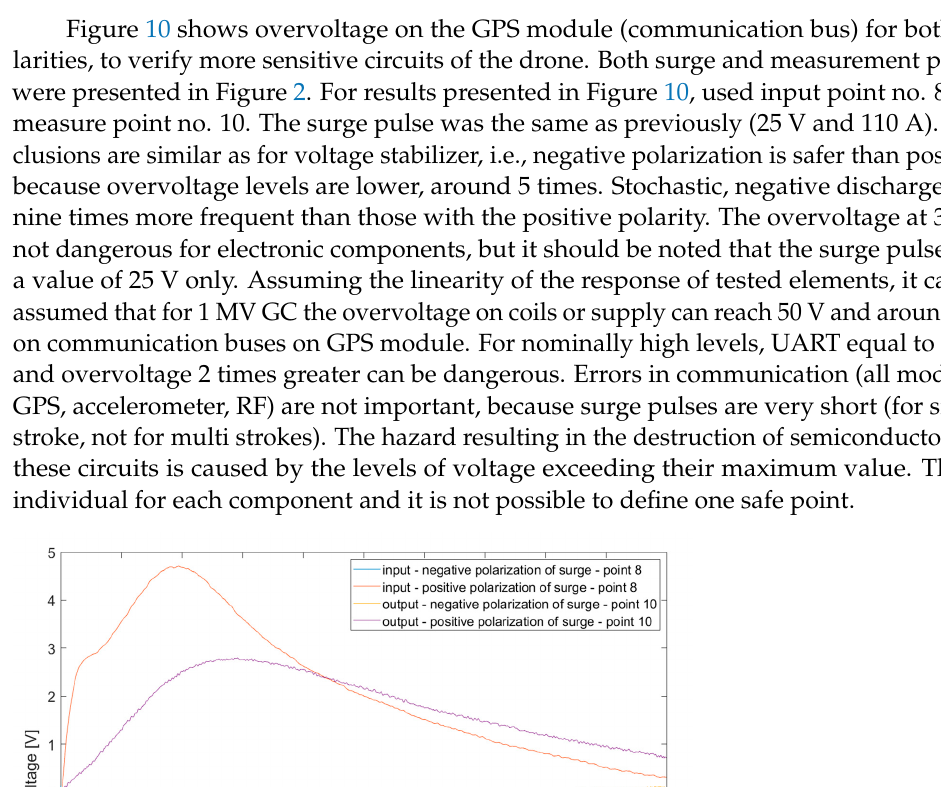
Figure 9. Overvoltage on output of voltage stabilizer (point 12) for both (negative and positive) polarity of surge pulse on supply bus (point 8).